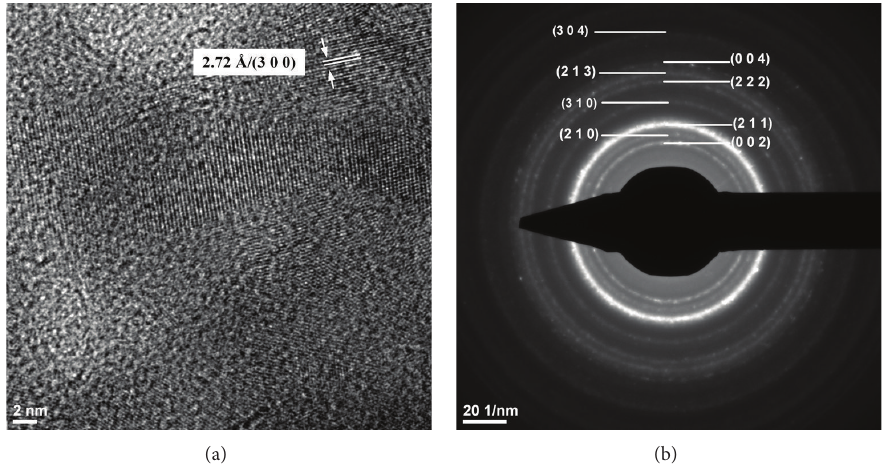
F 2: HRTEM image and SAED analysis of Ag:HAp with